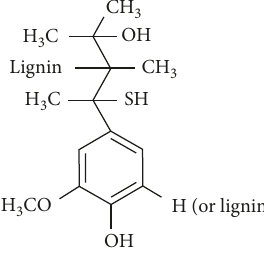
Figure 1: Kraft lignin structure